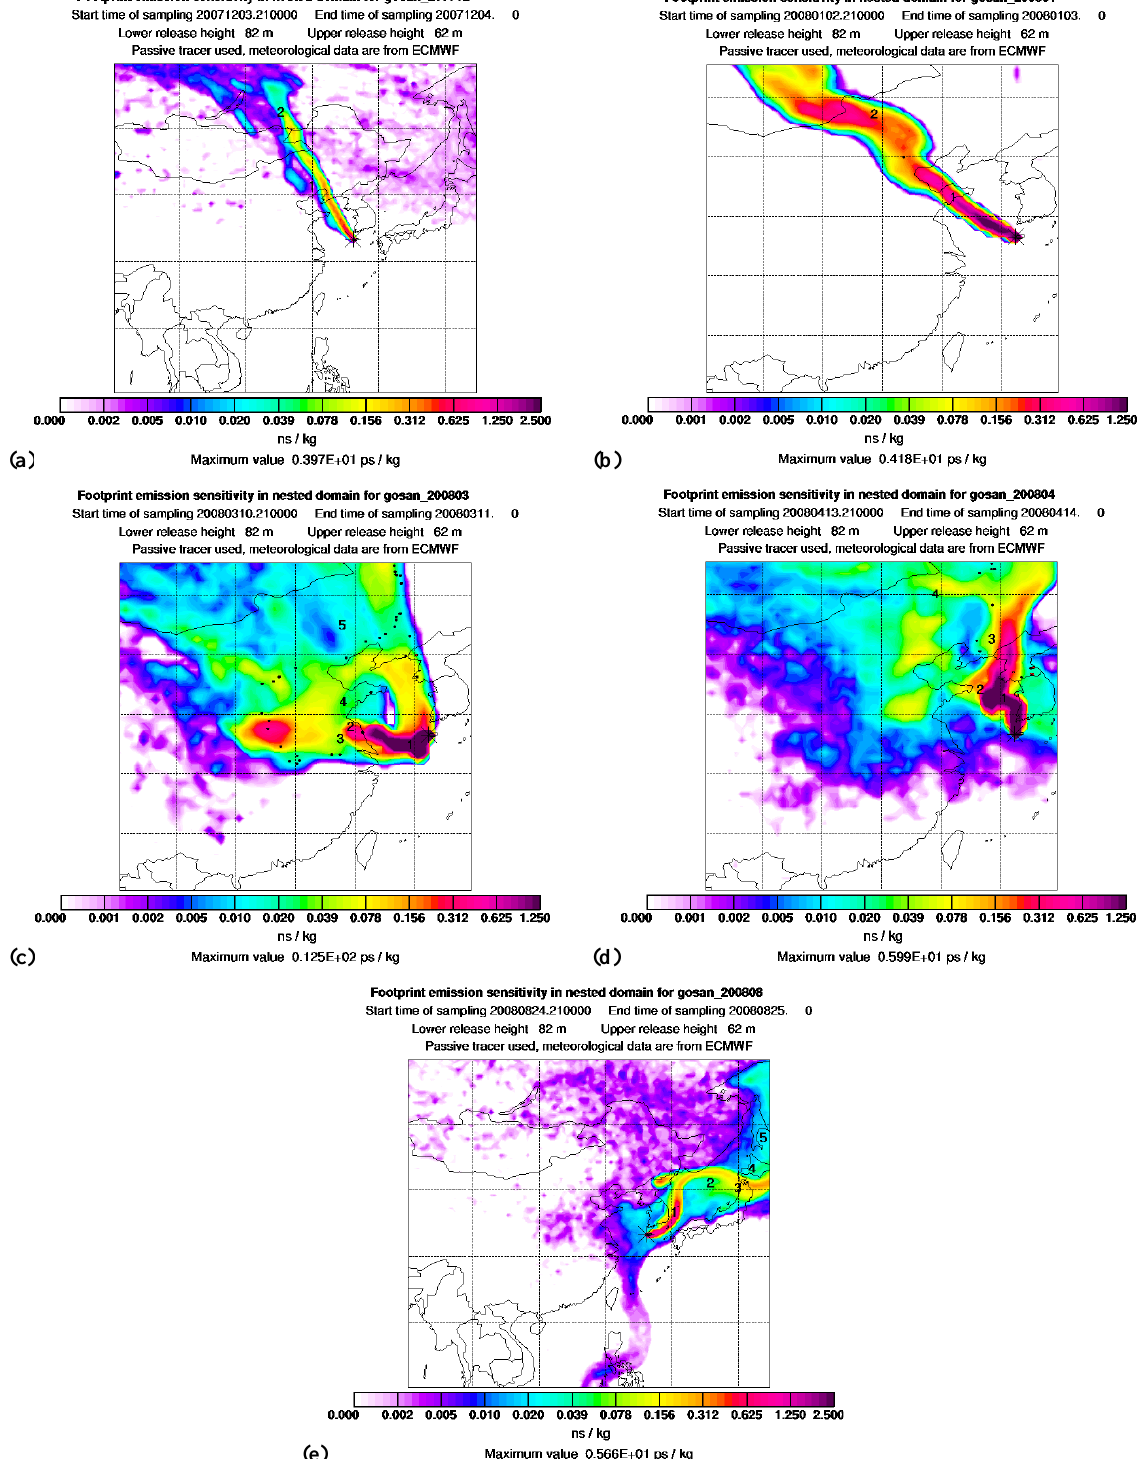
Fig. 9. Five air mass trajectories representing the influence from (a) Siberia region (e.g. 4 December 2007), (b) Beijing region (e.g. 3 Jan- uary 2008), (c) Shanghai region (e.g. 11 March 2008), (d) Yellow Sea region (e.g. 14 April 2008), and (e) East Sea region (e.g. 25 Au- Figure 9 gust 2008). Backward trajectories were calculated every 3h using the Lagrangian particle dispersion model FLEXPART (Stohl et al., 2005; http://zardoz.nilu.no/ ∼ andreas/STATIONS/GOSAN/index.html). The model output (skg − 1 ) is a potential emission sensitivity distribution of 40000 particles released in a particular grid cell at the measurement location and during the measurement interval and followed backward in time, which is proportional to the particle residence time in that